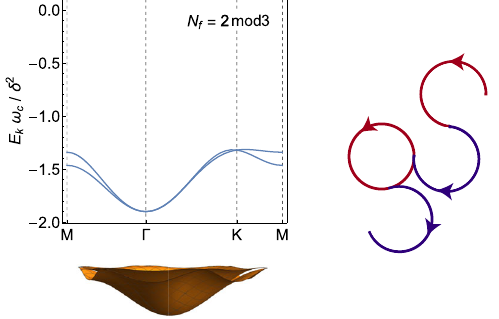
FIG. 8. Band structure due to skyrmion-antiskyrmion tunneling for N f ¼ 2 mod 3 and δ ¼ 0 . 1 ω c , where ω c is the cyclotron frequency. In contrast to the case shown in Fig. 7, the bandwidth is not linear in the tunneling rate δ but proportional to δ 2 = ω c . The splitting of the two bands is proportional to δ 3 = ω 2 c . The right- hand panel shows the trajectory of a classical particle in a magnetic field with random changes of the sign of the charge to mimic tunneling skyrmion-antiskyrmion tunneling